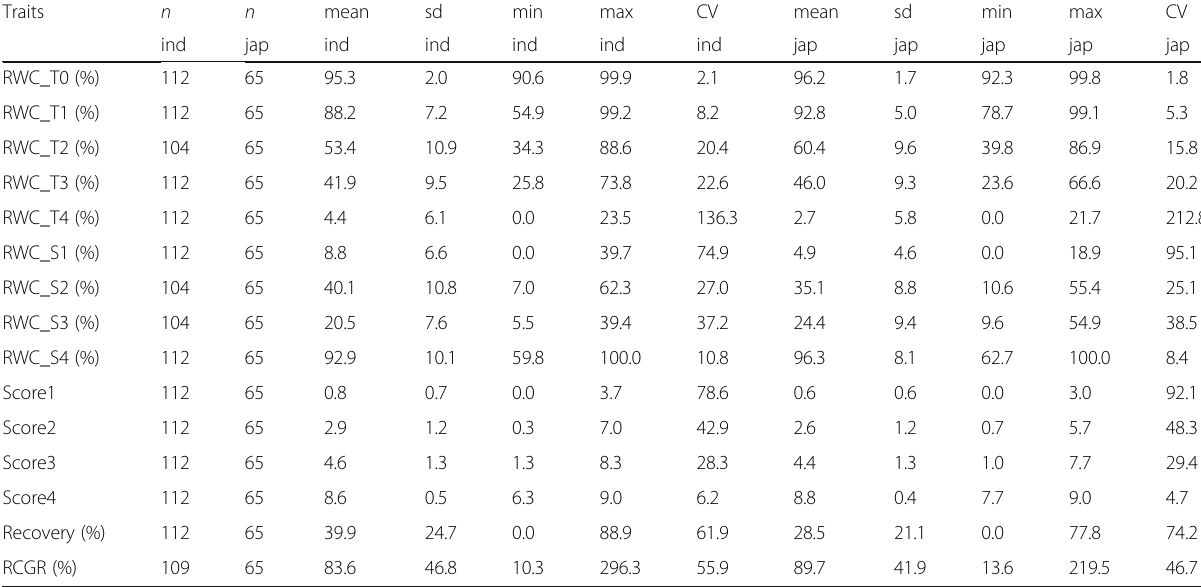
Table 2 Descriptive statistics of the indica (ind) and japonica (jap) subpanels for selected traits Traits